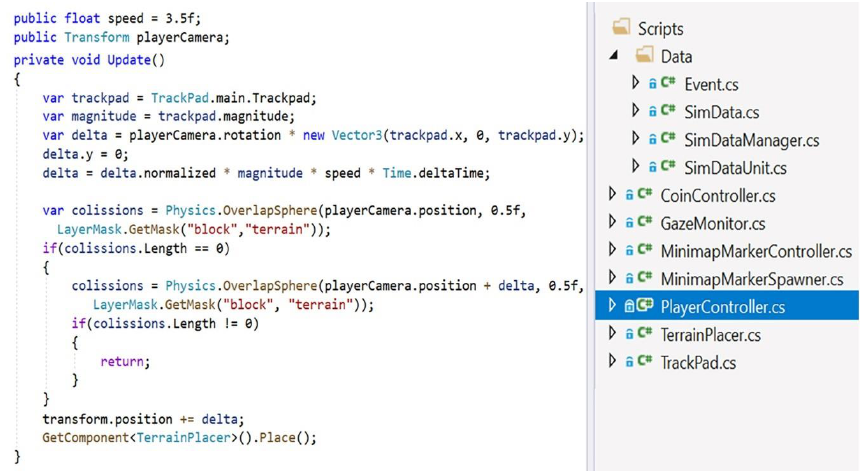
Figure 3. Script PlayerController.cs and list of written programming scripts for running the game